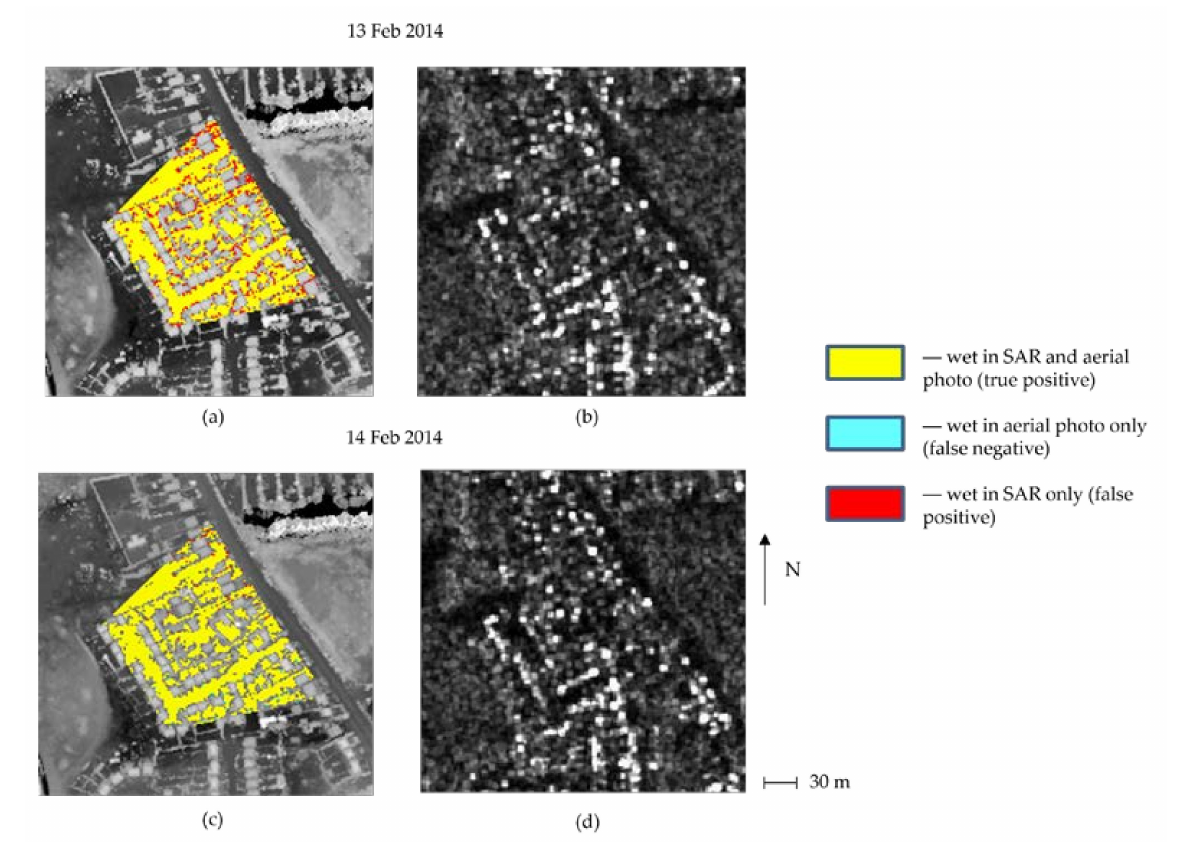
Figure 7. ( a ) Correspondence between the SAR image of 13 February 2014 and aerial photograph flood extents in the urban area of Blackett Close, superimposed on the LiDAR image (lighter grey – higher) and ( b ) extract from the SAR image of 13 February 2014; ( c , d ) as ( a , b ) for the SAR image of 14 February 2014.